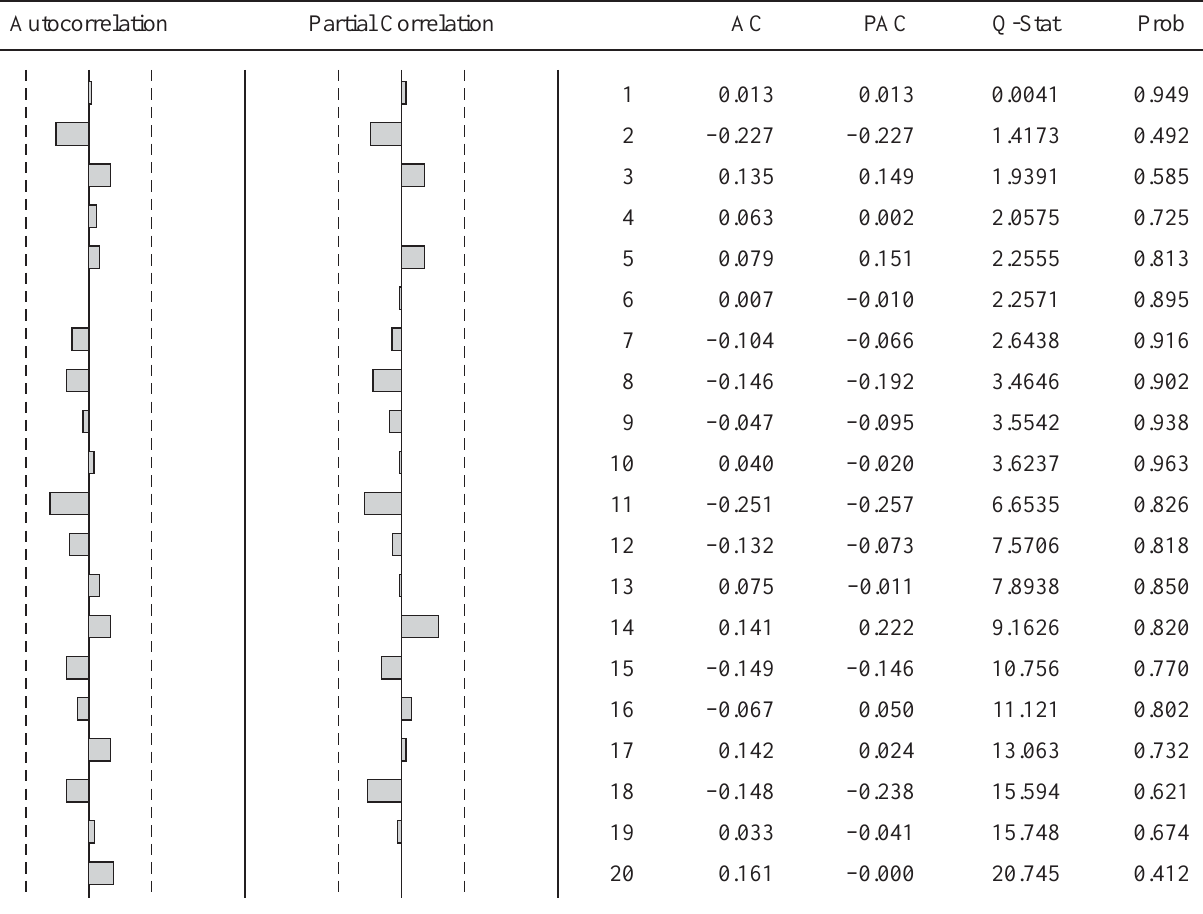
Table B. Autocorrelation of the residuals (Sample: 1999:1